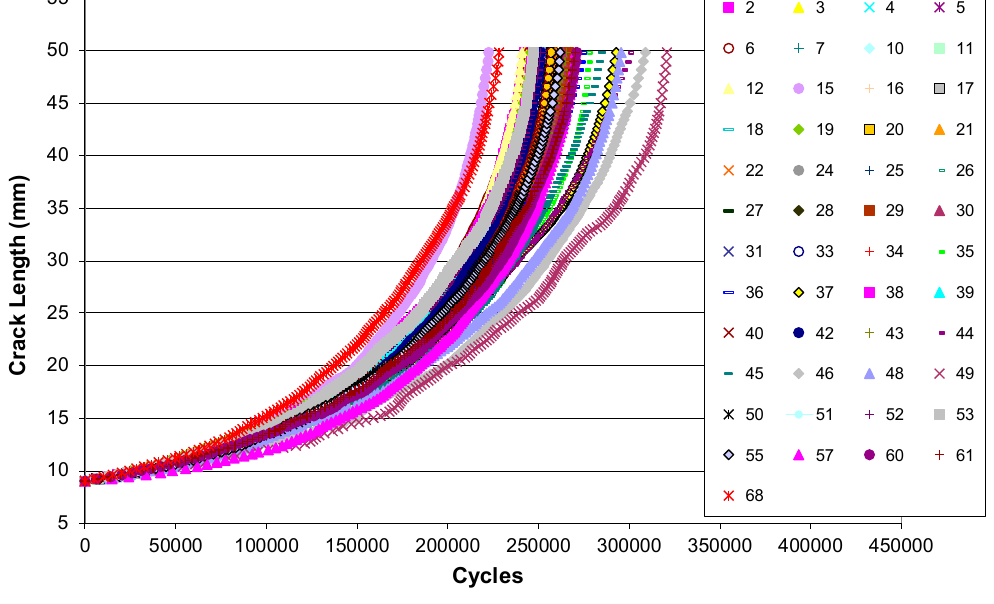
Figure 13. The variability in the crack length histories reported in [46].